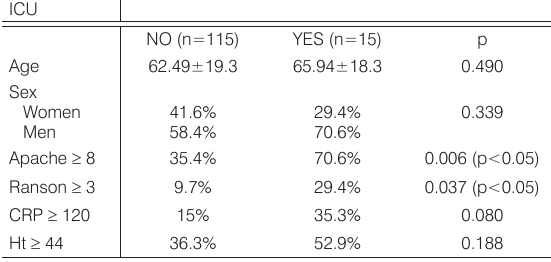
Table 2. Sensitivity, specificity, PPV and NPV of various EPMs predicting severity, necrosis and mortality.